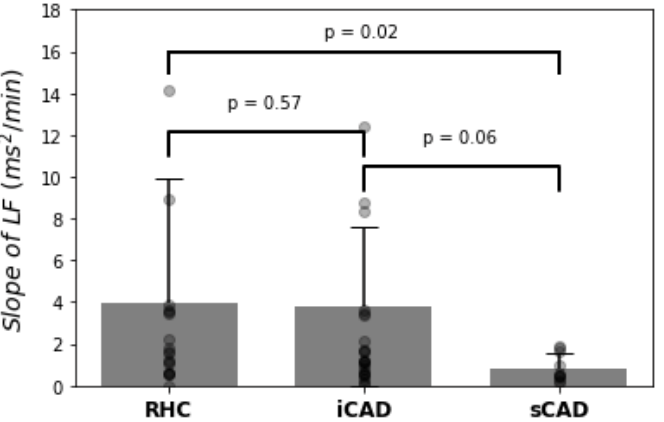
Figure 4. The slope of the linear regression from the Max to the R6 stages of LF for each of the 54